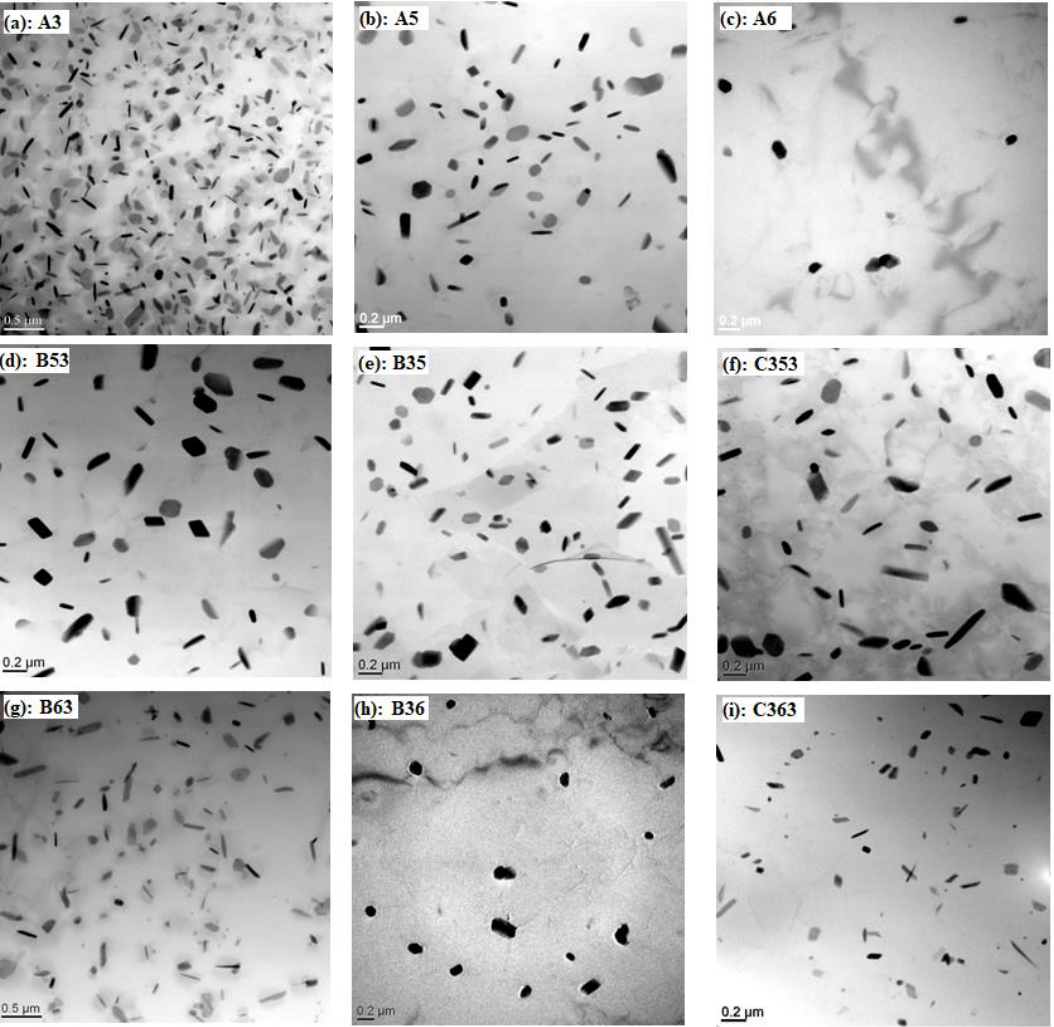
Figure 4. Distribution of dispersoids during heat treatment under TEM observation: ( a ) A3 , ( b ) A5, ( c ) A6, ( d ) B53, ( e ) B35, ( f ) C353, ( g ) B63, ( h ) B36 and ( i ) C363.